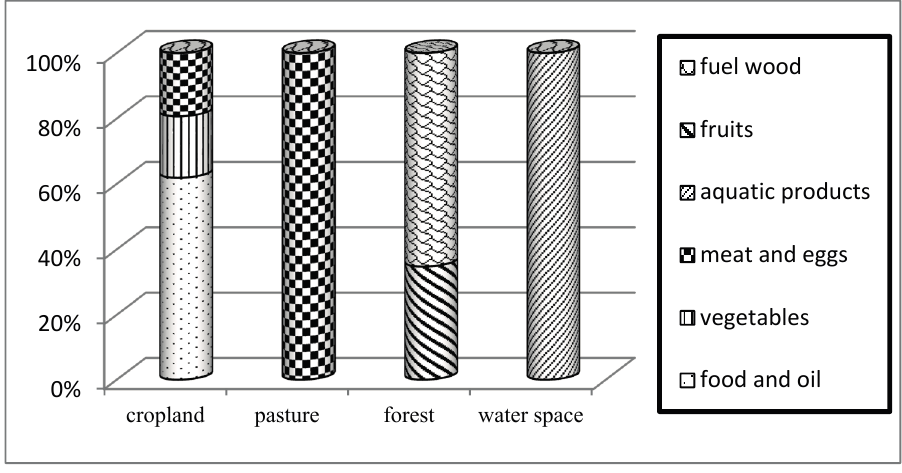
Figure 2. The ratios of the EFs from consumption of biological products in